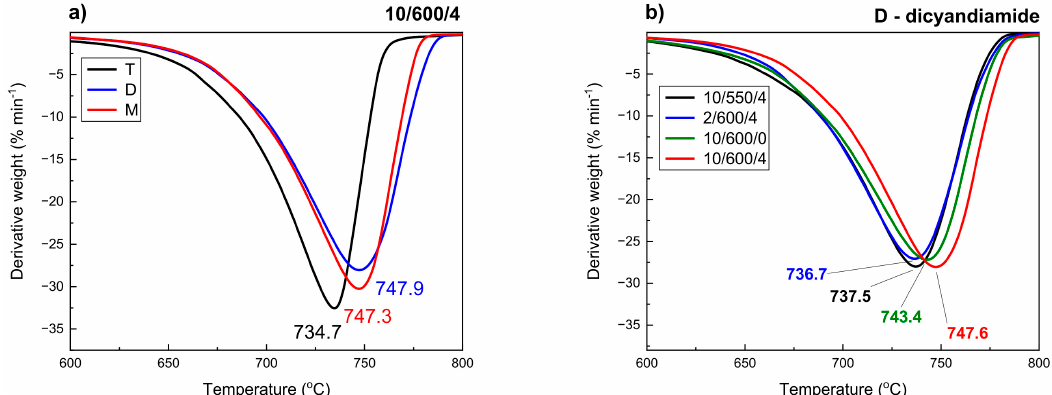
Figure 9. DTG curves of carbon nitrides obtained from different precursors ( a ) and under different condensation conditions from dicyandiamide ( b ).